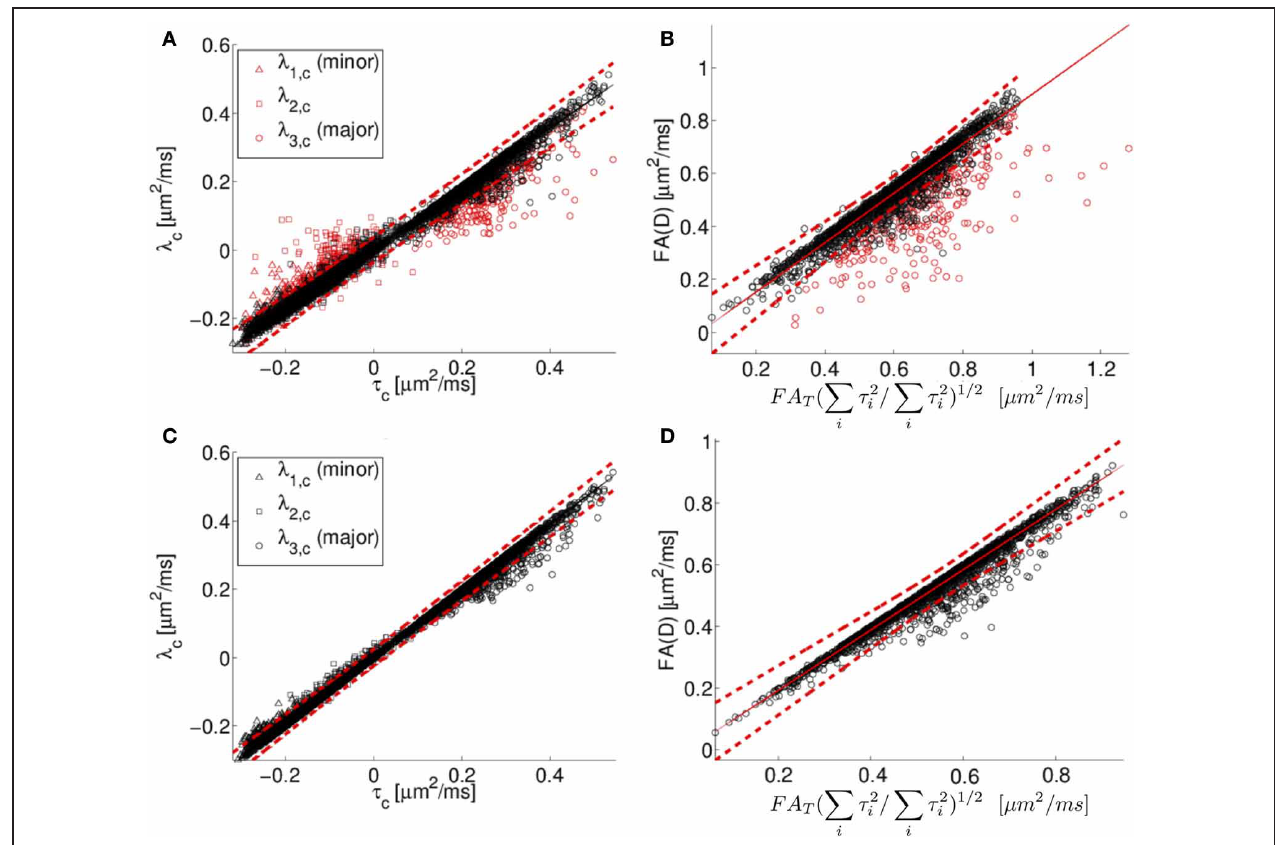
diffusion MRI data using a cumulant expansion expression are presented for centralized eigenvalues (C) and FA (D) . The black and red symbols correspond to points where the DTI model explains more (black) or less (red) than 95% of the signal variation. Human neocortical neurons from the NeuroMorpho.org database were used for this analysis. The eigenvalues are in units of μ m 2